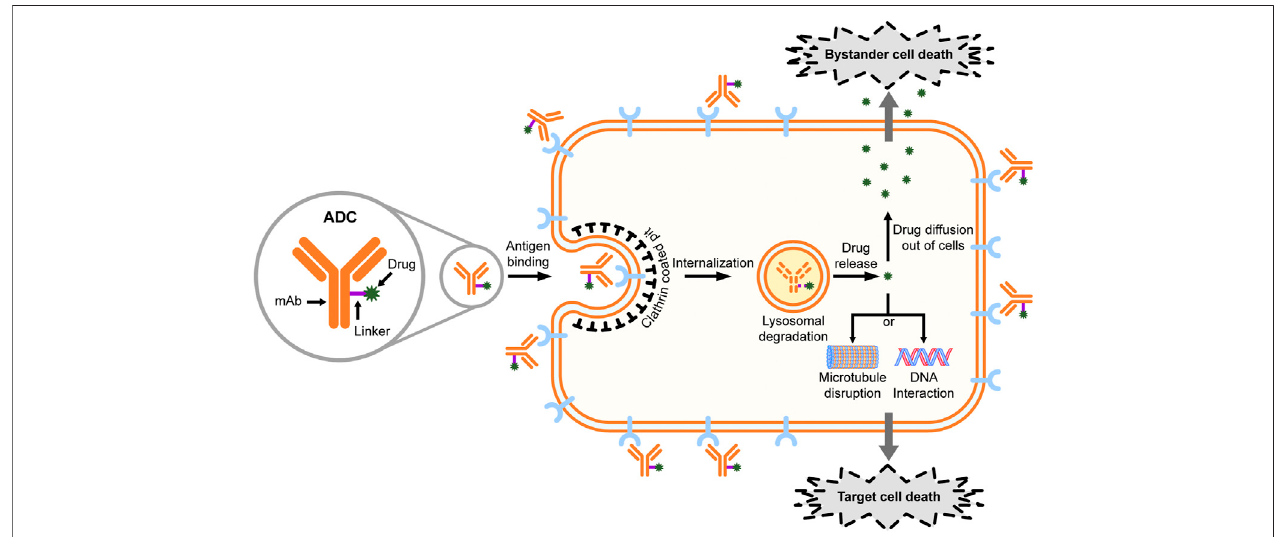
FIGURE 1 | Structure and mechanism of action of antibody-drug conjugates